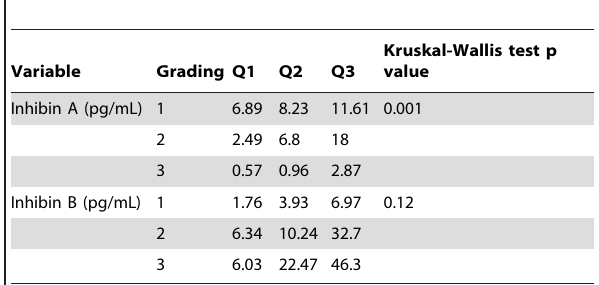
Table 3. Inhibin A and Inhibin B and concentrations in relation to grading.